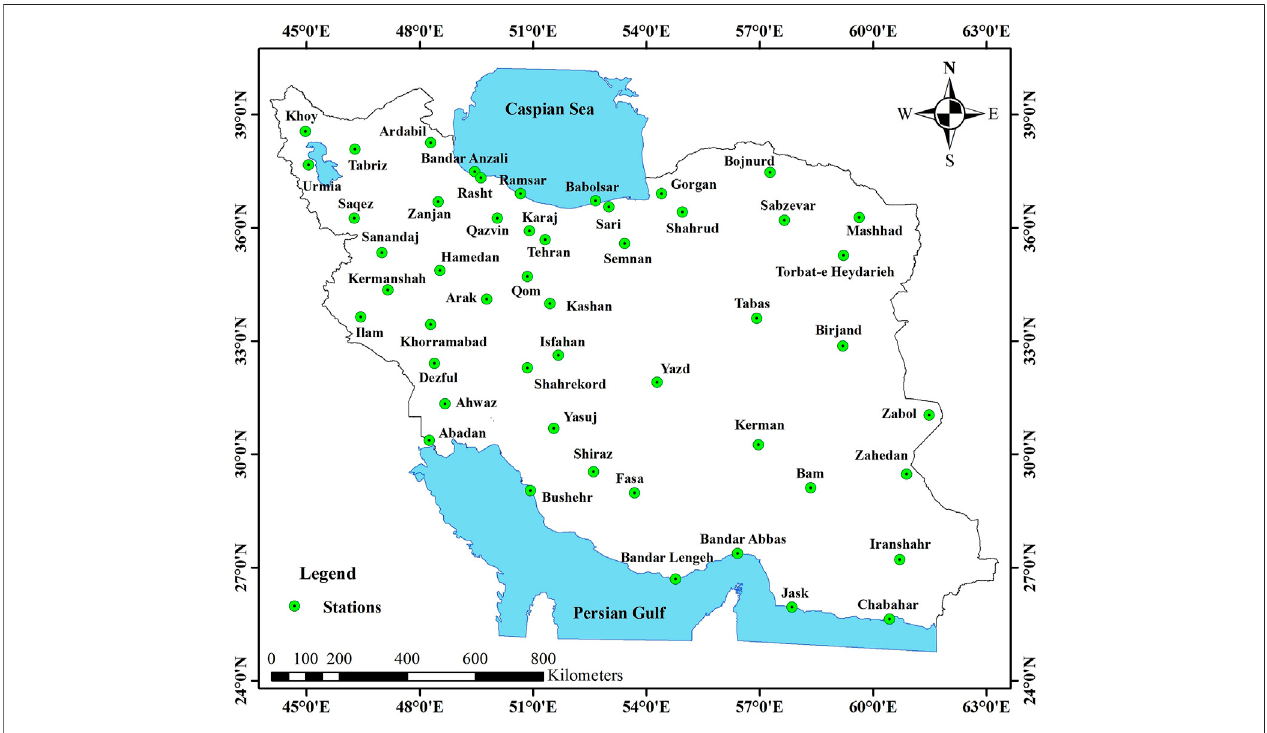
FIGURE 1 | Spatial distribution of the studied stations in